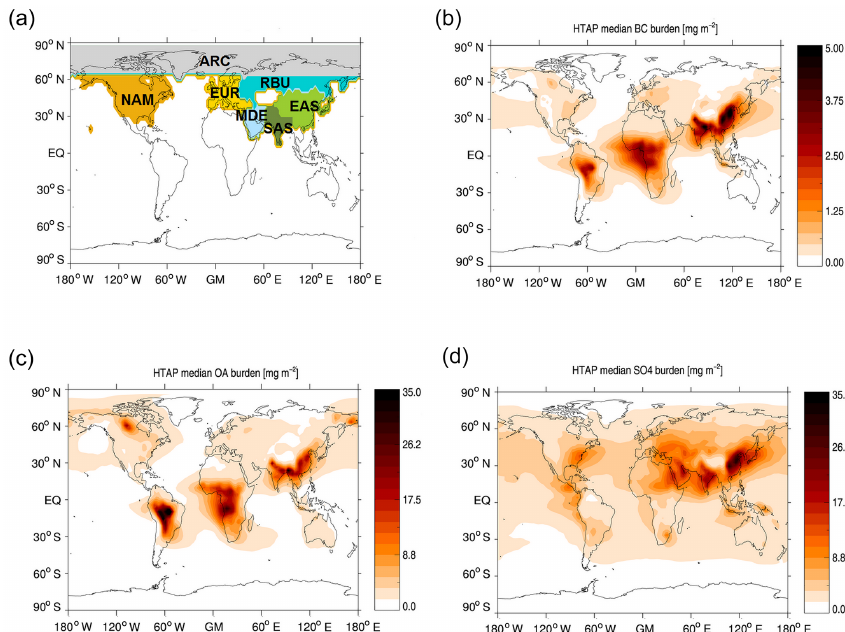
Figure 1. (a) Regions of focus (NAM: North America; EUR: Europe; EAS: east Asia; SAS: south Asia; RBU; Russia/Belarussia/Ukraine, MDE: Middle East and ARC: Arctic). Panels (b, c, d) show multi-model median (calculated at each grid point), annual mean aerosol load of the BASE experiment for BC, OA and SO 4 ,